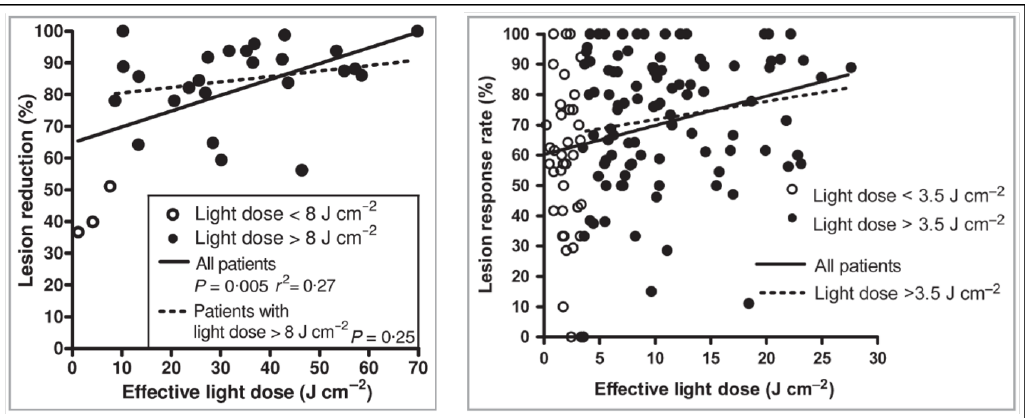
Figure 3. From [8,9]. Left, minimum PpIX-e ff ective light dose threshold of 8 J cm − 2 shown for patients with grade I AK lesions. Right, minimum PpIX-e ff ective light dose threshold of 3.5 J cm − 2 shown for all grades of